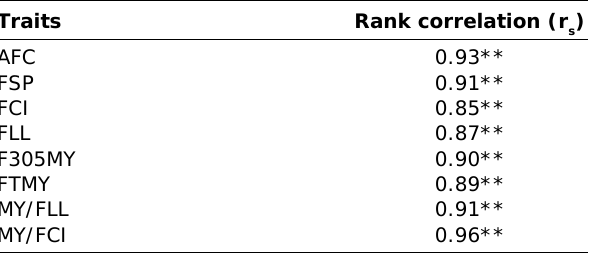
Table-5: Rank correlation (r of first lactation traits estimated from univariate SLS, sire model and animal model.